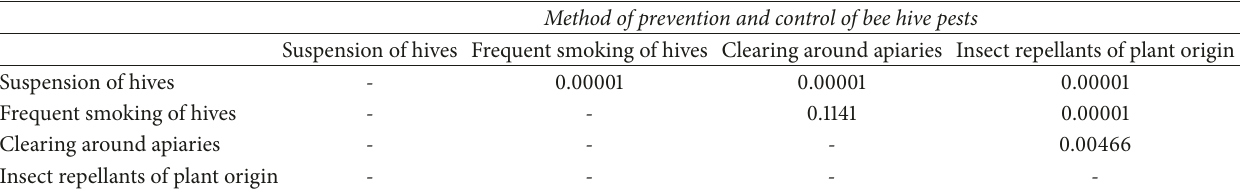
Table 4: P-value matrix for cross tabulation of respondents’ preferred method of prevention and control of bee hive pests.